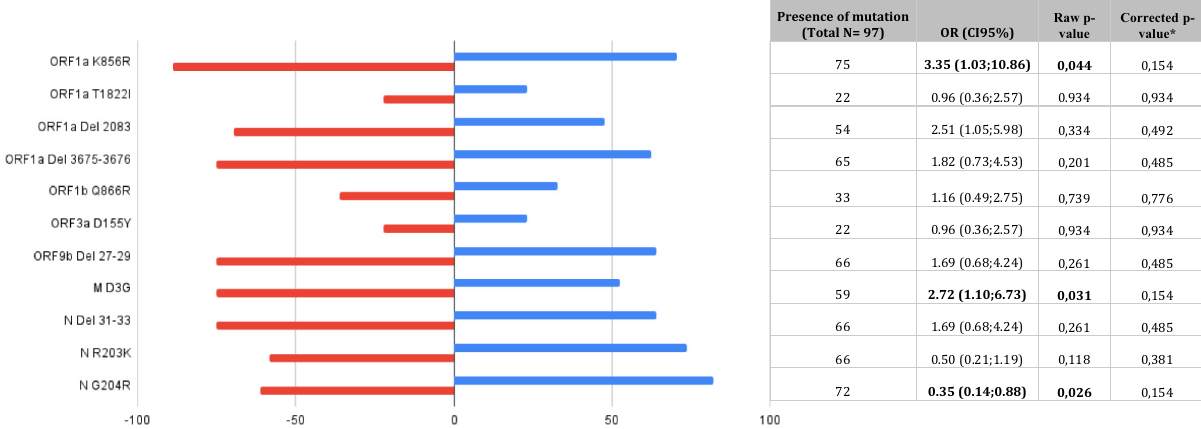
signi fi cantly associated with day-28 mortality but this relationship was no longer signi fi cant after correction of p -values for test multiplicity using the Benjamini – Hochberg procedure. Day 28 mortality is displayed in red and day 28 survival in blue; p -values come from unadjusted logistic regression modeling. Horizontal bars represent percentages; Source data are provided as a Source Data fi